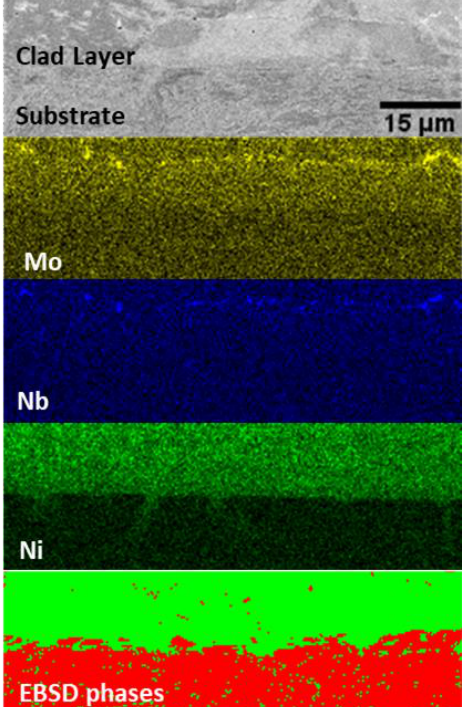
Figure 11. SEM image and elemental maps obtained by EDX microanalysis of M625 deposited on preheated (PHT) 42CrMo4 substrate. An EBSD image shows the phase distribution in this region: FCC phases in green and BCC phases in red.